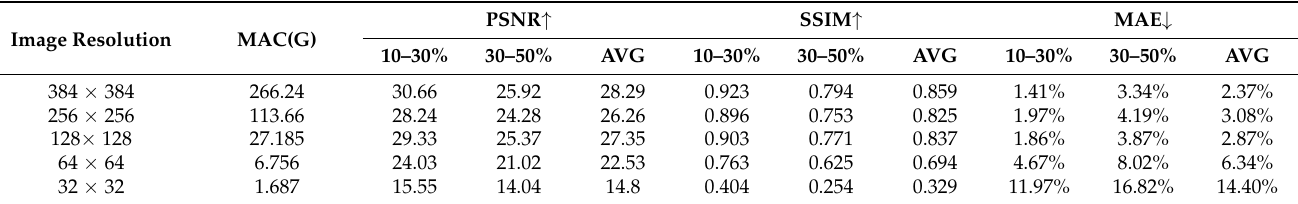
Table 9. Evaluation metrics on diverse resolution input images of the AID